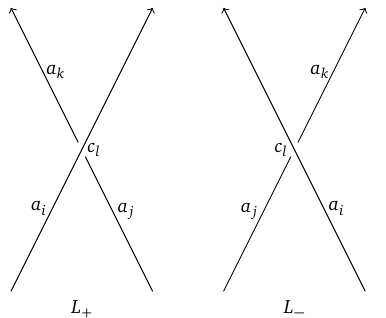
Figure 5: Illustration of the convention of the signatures of the crossings, where the arrows indicates the orientation. L + and L − are what we refer to as positive and negative crossings respectively. Generally, k = j + 1 due to how the arcs are defined.